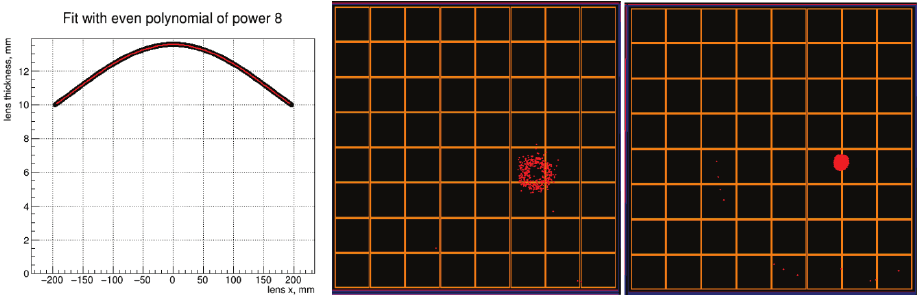
Figure 8: Left: The cross-section view of the corrector lens. Center: Photons induced by many UHECRs from 100 PeV protons, with equal parameters, superimposed on the camera plane. Right: PSF at the same location on the camera plane.